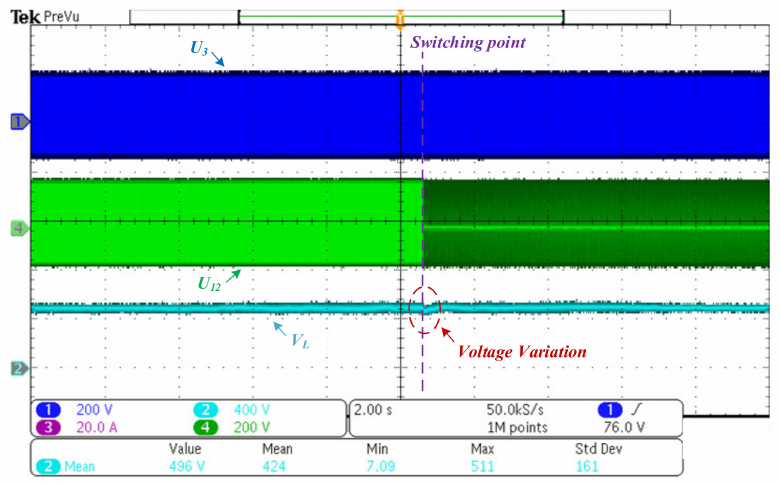
Figure 14. The dynamic response at the switching point.